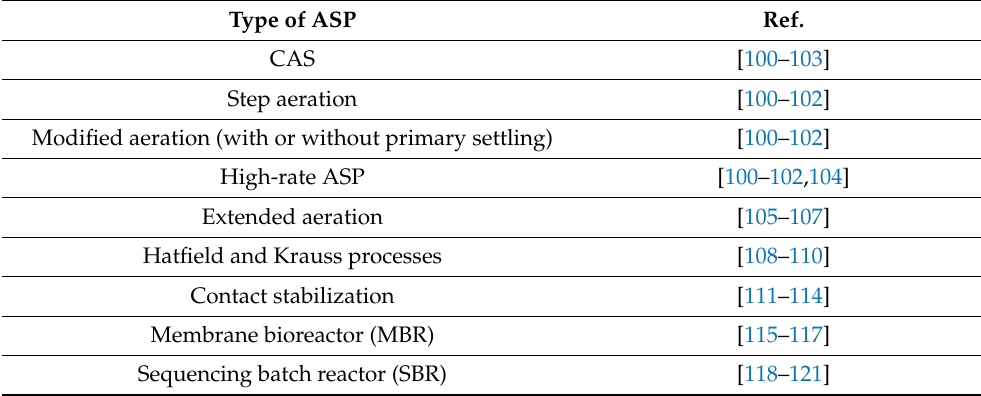
Table 2. Most common ASP configurations.